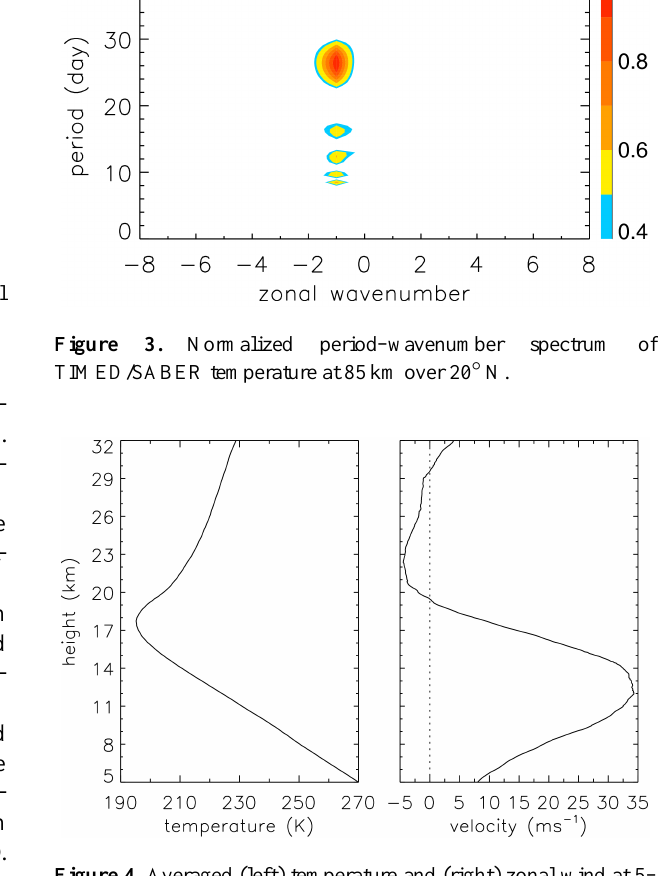
Figure 4. Averaged (left) temperature and (right) zonal wind at 5– 32km from radiosonde observations over